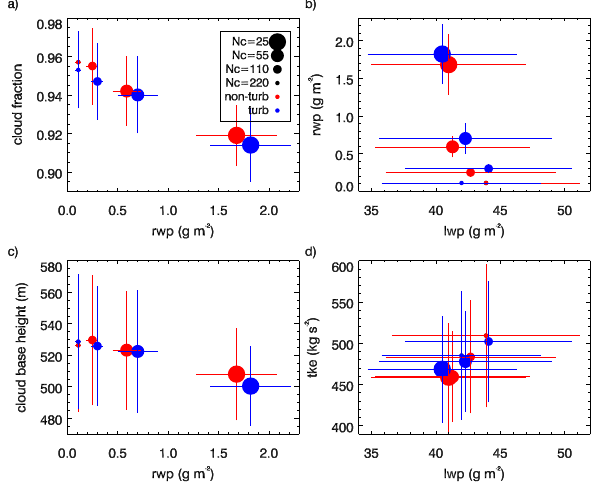
Figure 10. Average DYCOMS II cloud and dynamical properties for specified CDNC. Rain water path (gm − 2 ) and (a) cloud frac- tion and (c) cloud base height (m). Liquid water path (gm − 2 ) and (b) rain water path (gm − 2 ) and (d) vertically integrated turbulent kinetic energy (kgs − 2 ) . The length of the bars denote the ± standard deviations about the mean.